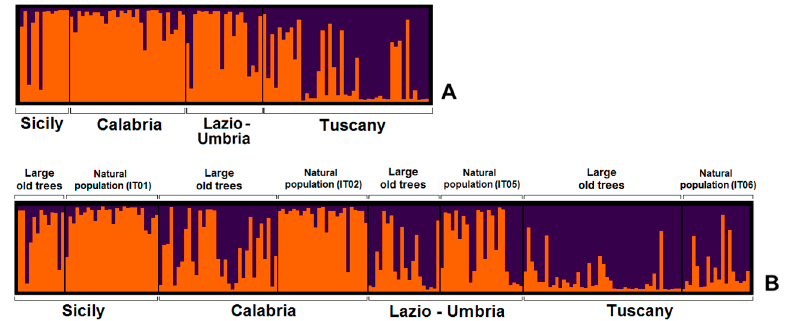
Figure 2. Estimated genetic structure ( A ) the large old trees and ( B ) large old trees and natural population living in the proximity. The different gene pools are revealed by STRUCTURE analysis, using the admixture model for Δ K = 2. Each individual is represented by vertical lines; groups of individuals are separated by vertical black lines. Different colors in the same line indicate the individuals’ estimated membership percentage in the K clusters (Q values). Orange = cluster I; Purple = cluster II.